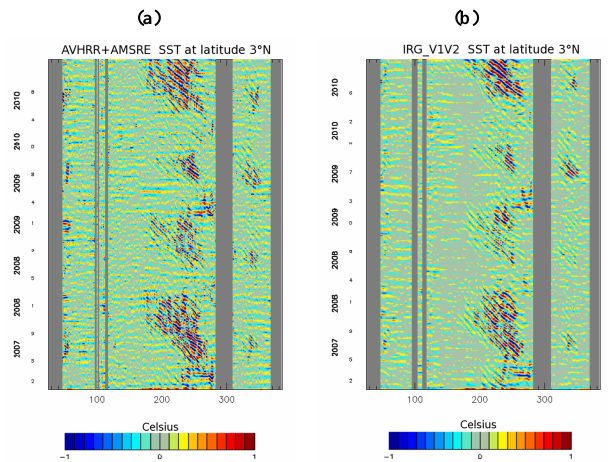
Fig. 23. SST longitude–time diagrams at 3 ◦ N over the world ocean. SST from AVHRR+AMSRE (a) , IRG V1V2 (b) are high-pass filtered to keep fluctuations at periods shorter than 43 days.